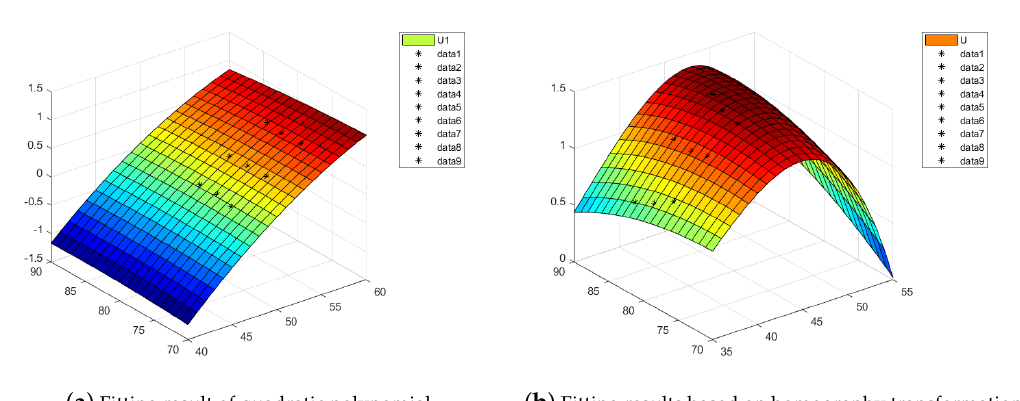
Figure 10. Schematic diagram of gaze point abscissa surface